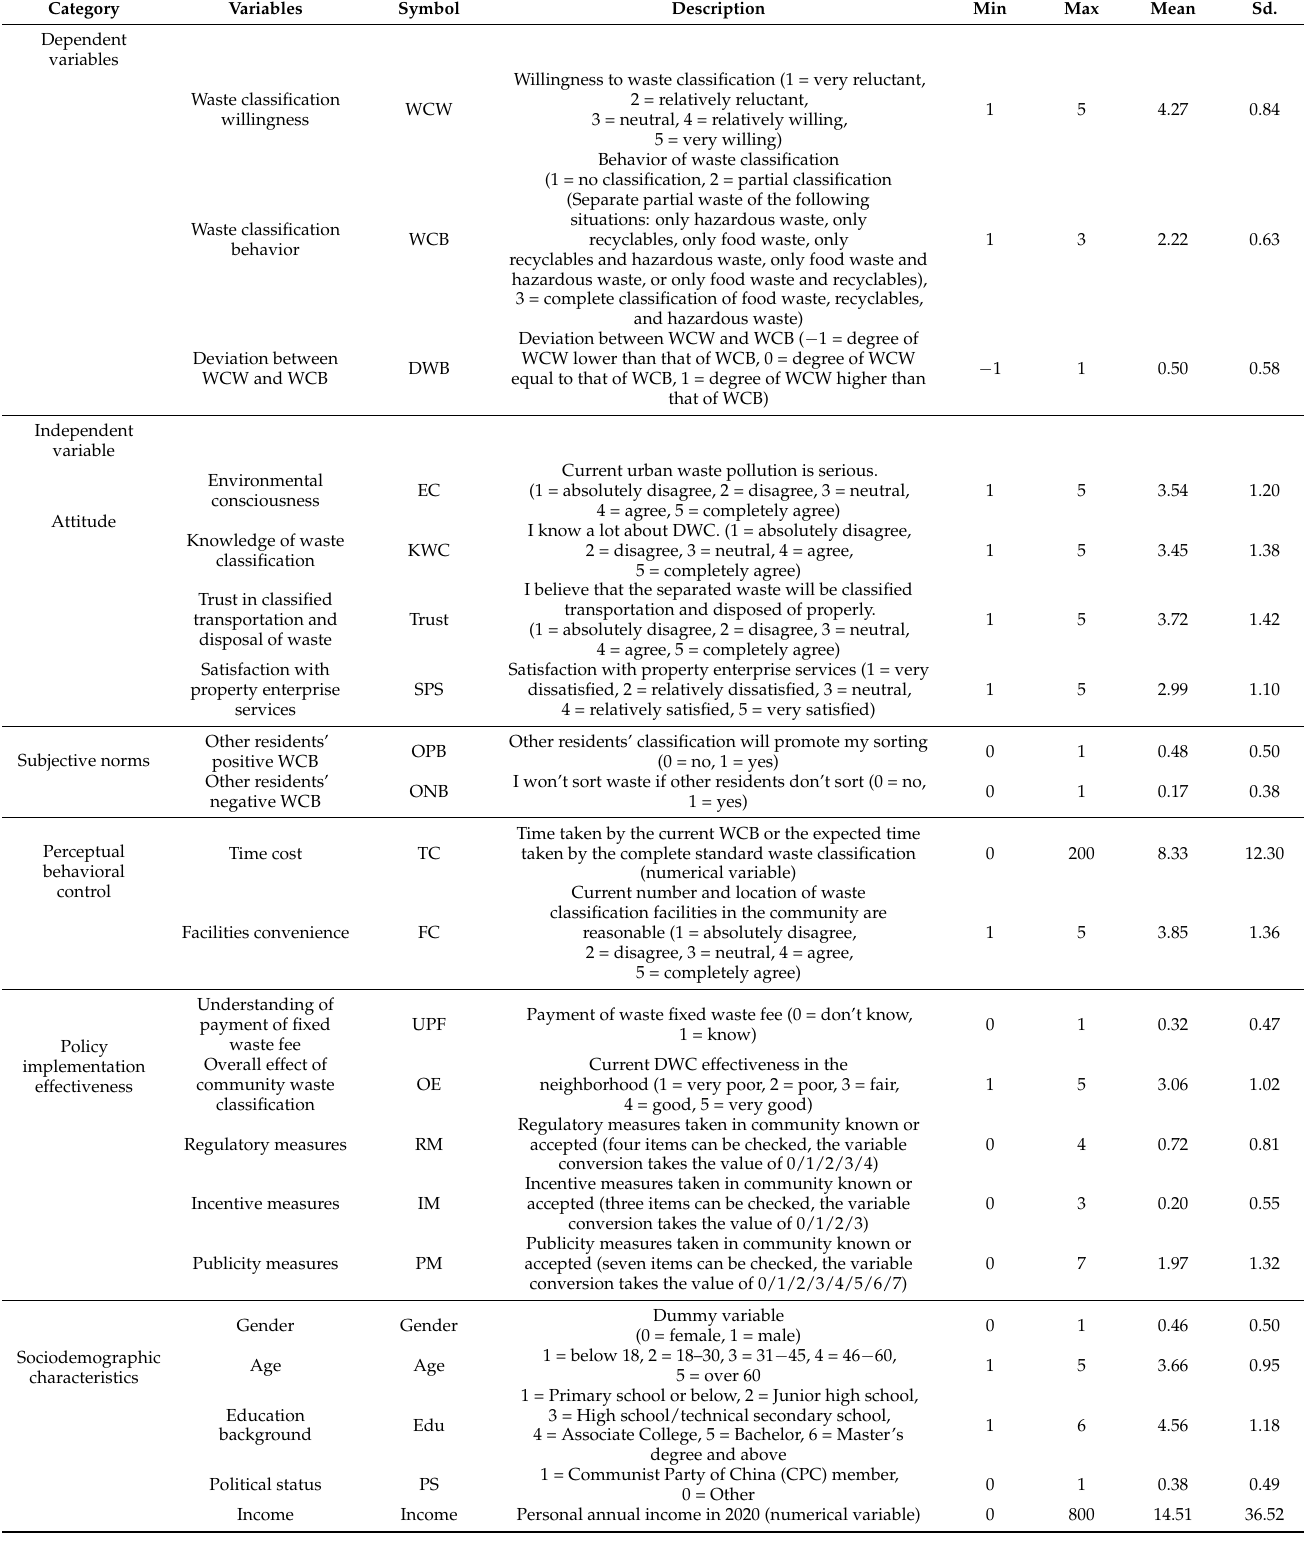
Table 2. The definitions and descriptive statistics of the